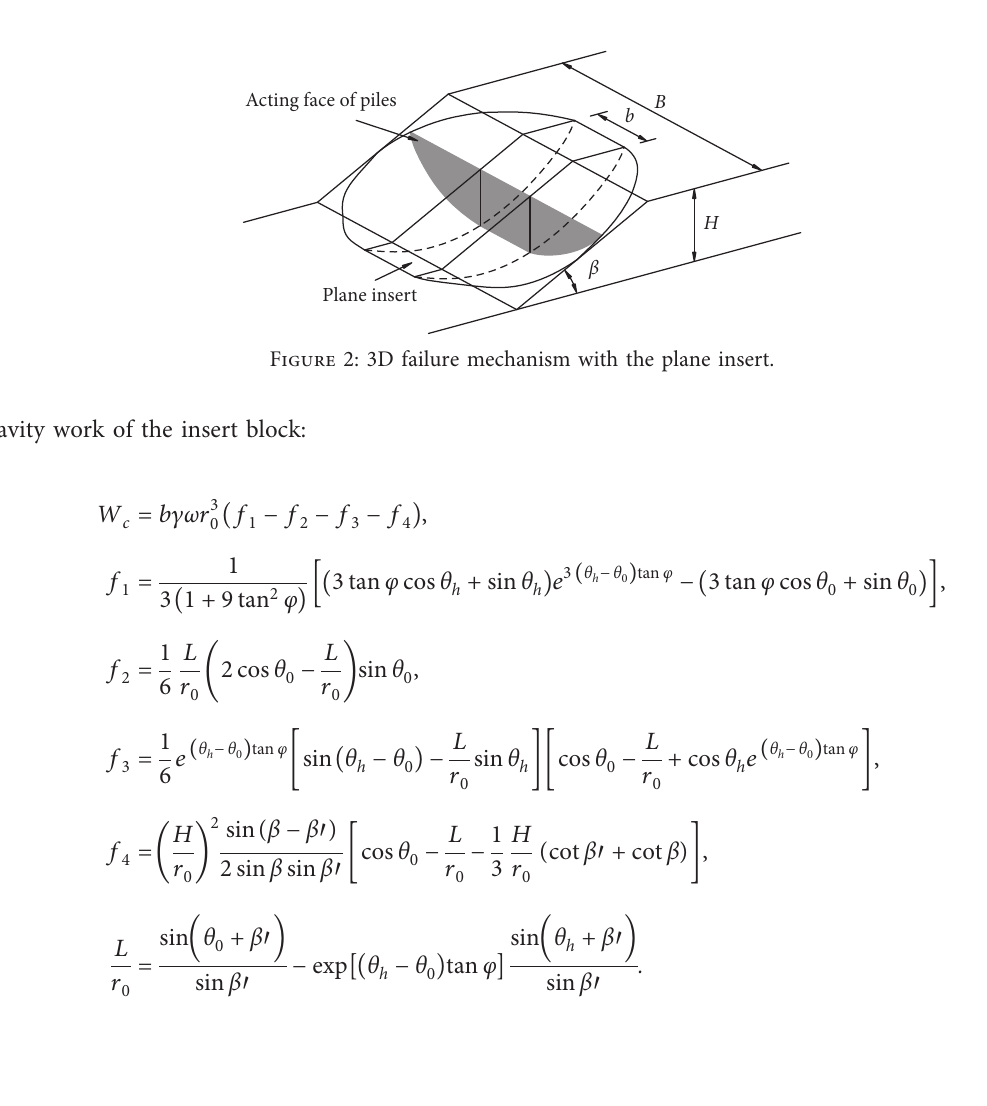
Figure 1: 3D rotational failure mechanism.